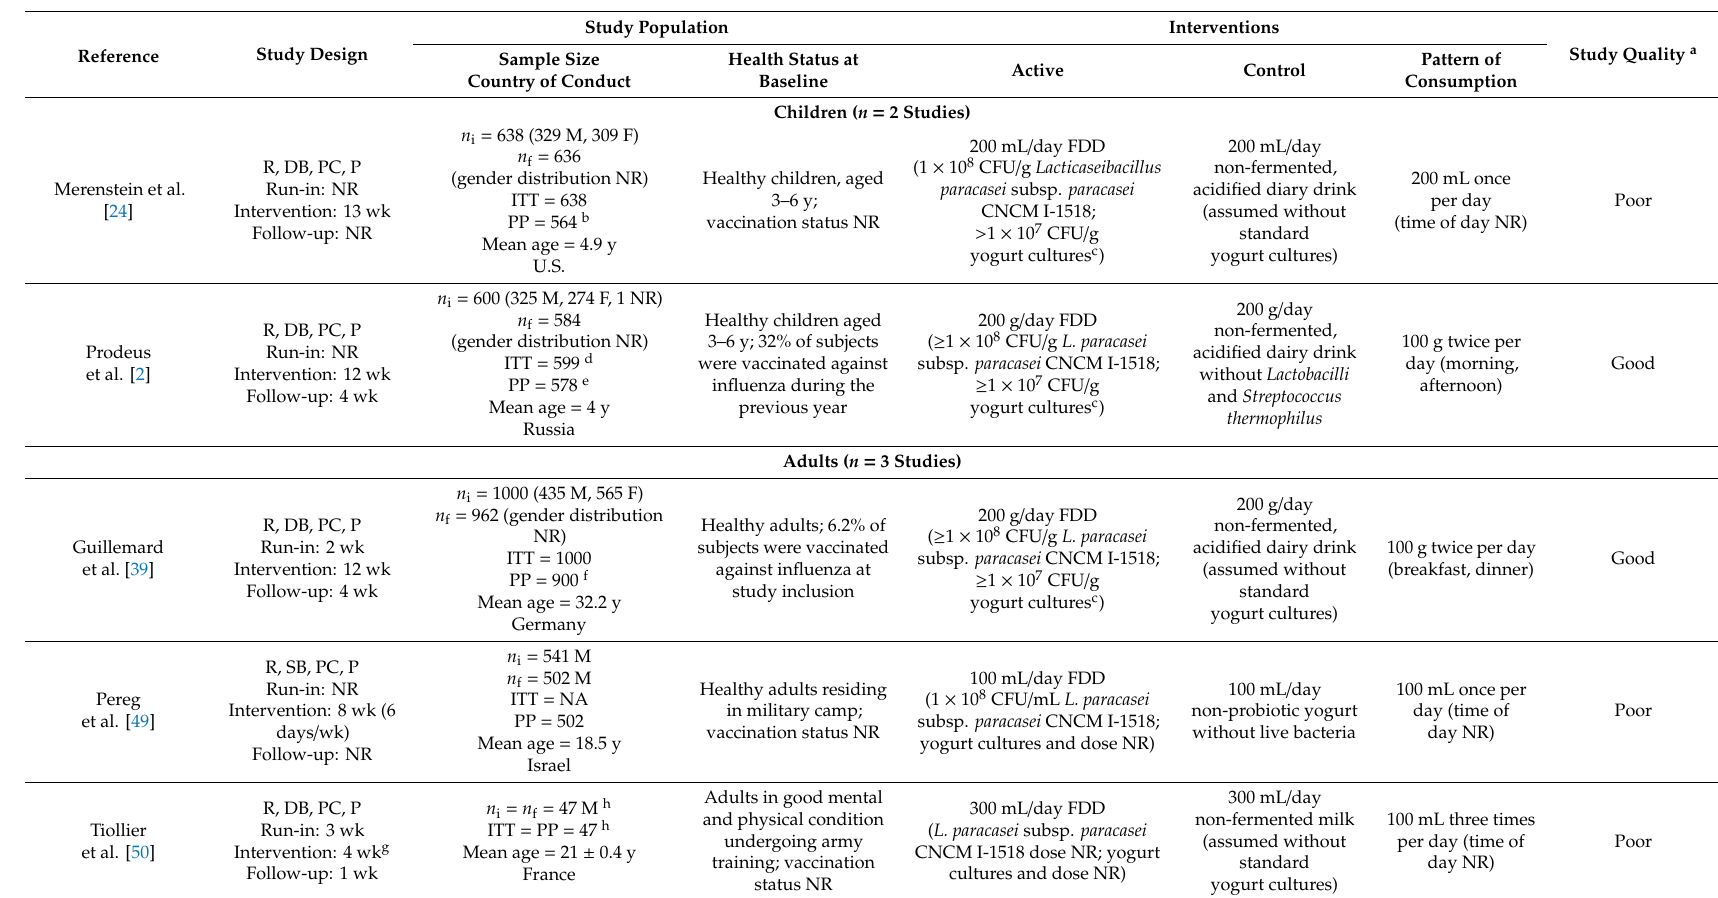
Table 2. Key characteristics of included studies ( n = 9 studies from 8